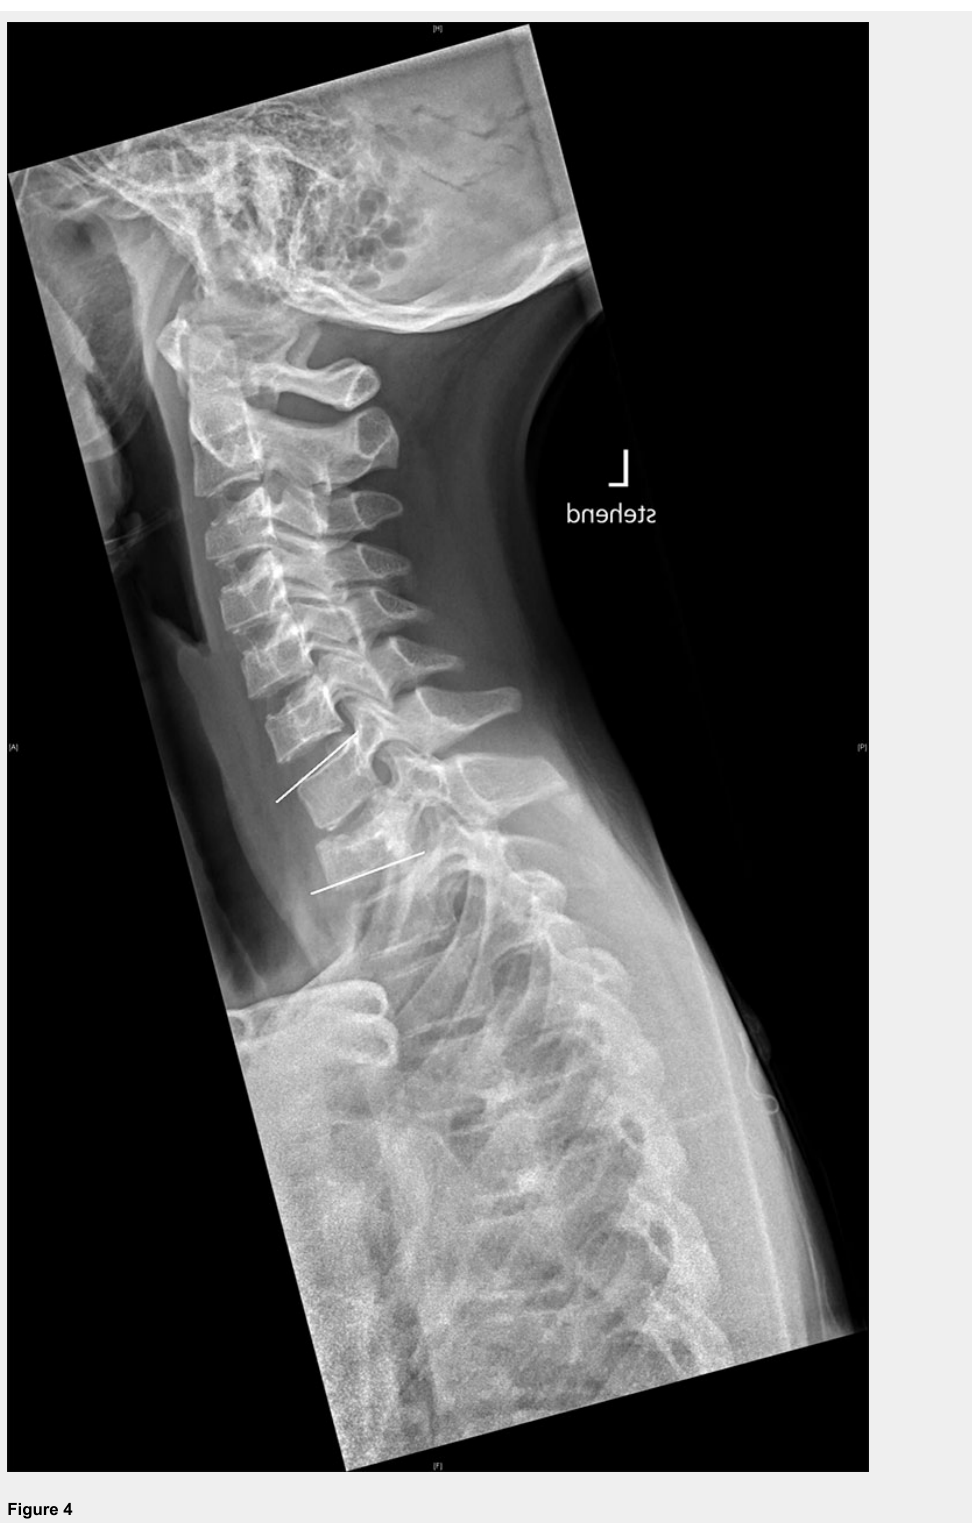
Figure 4 11.5-year-old boy with a T1 compression fracture after a fall (hyperflexion mechanism) with his bike ( A ). Segmental kyphosis may be underestimated on a CT